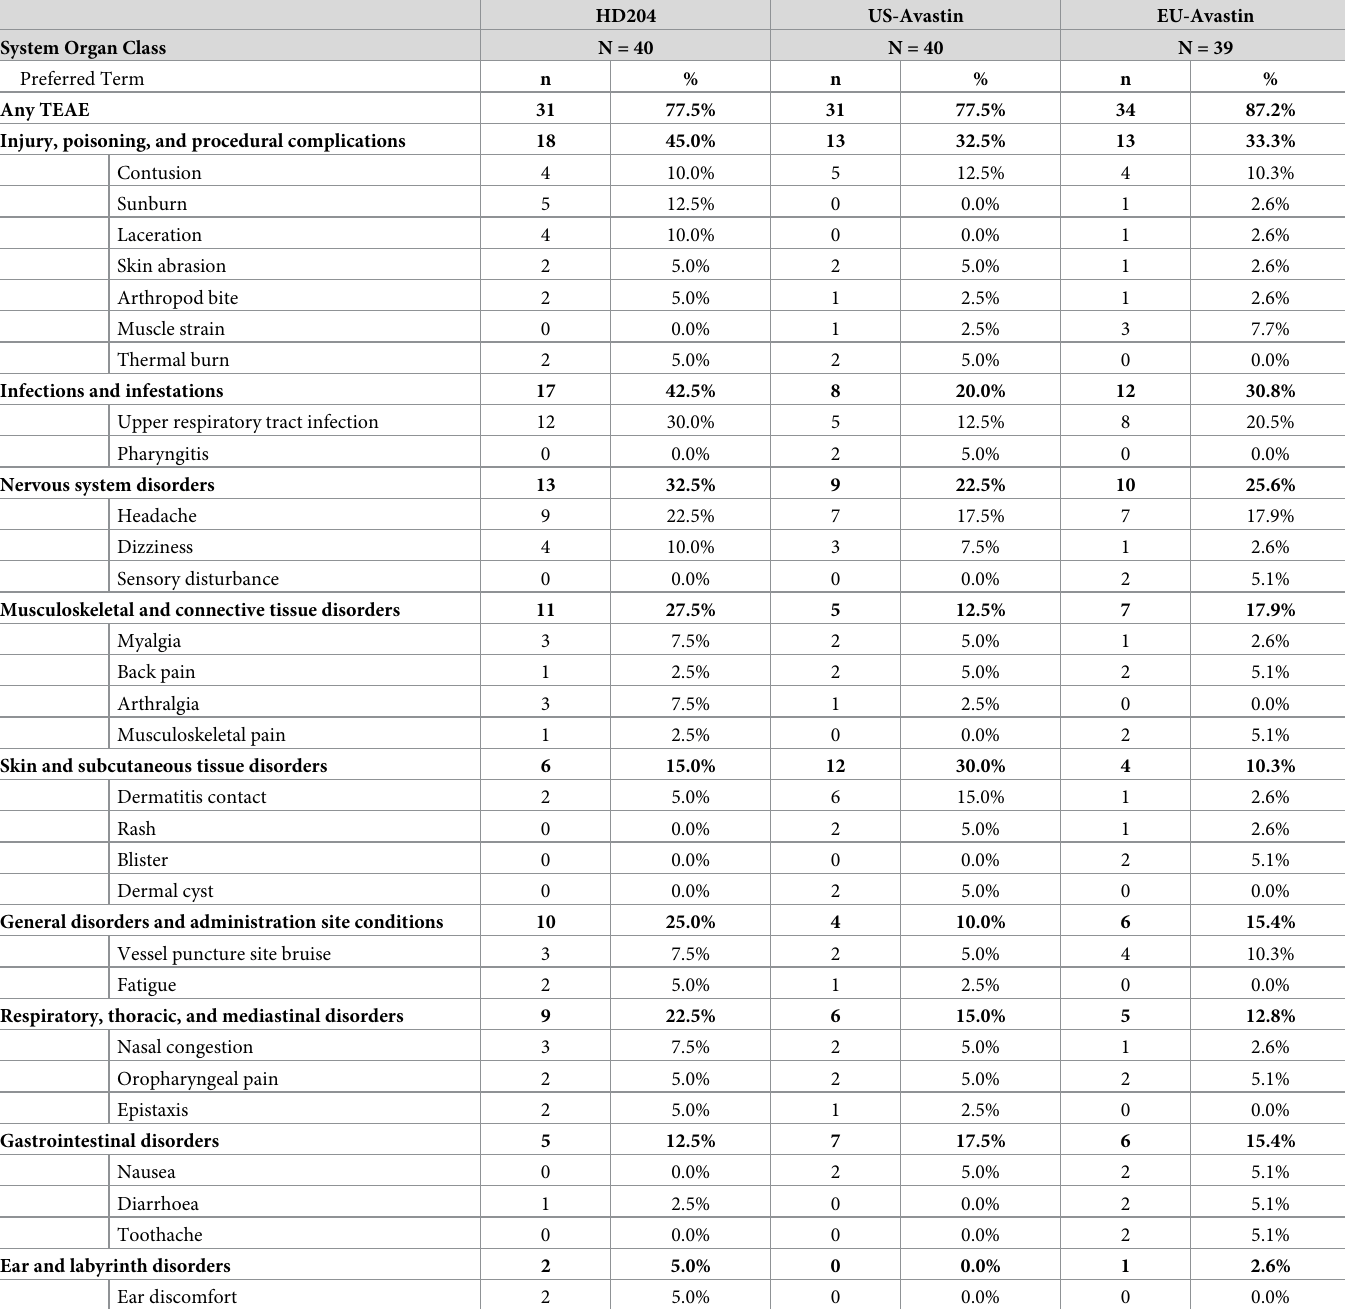
Table 4. Subjects with TEAEs by SOC and PT, reported � 5% in any